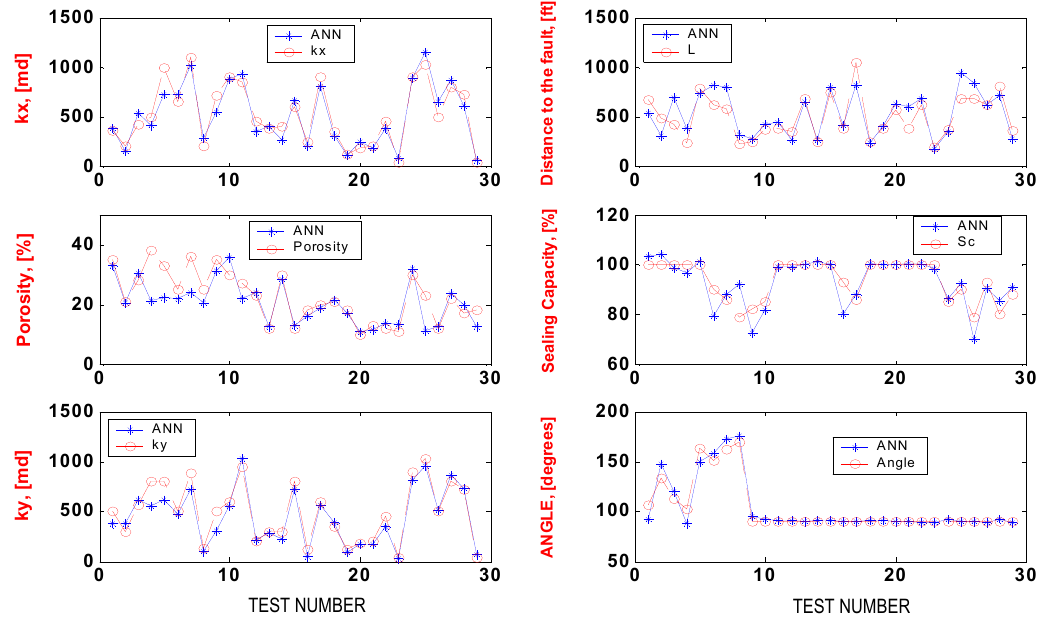
Figure 9. A blind testing case results from the sub-ANN trained for six cycles Figure 10. Comparison of the predicted and actual characteristics of a faulted reservoir.